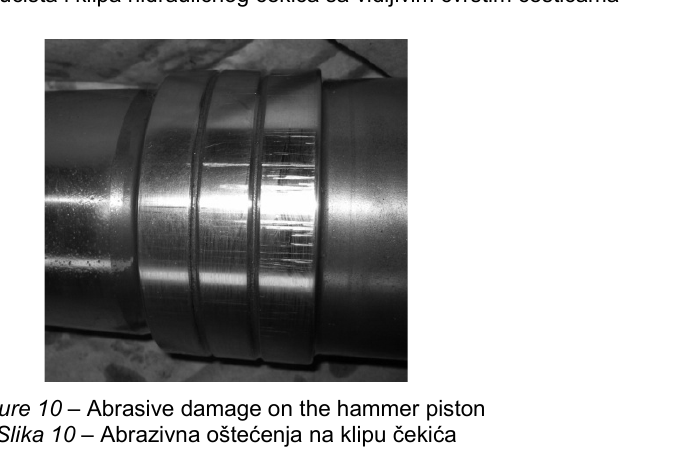
Figure 9 – The assembly of the housing and the piston of the hammer with solid particles